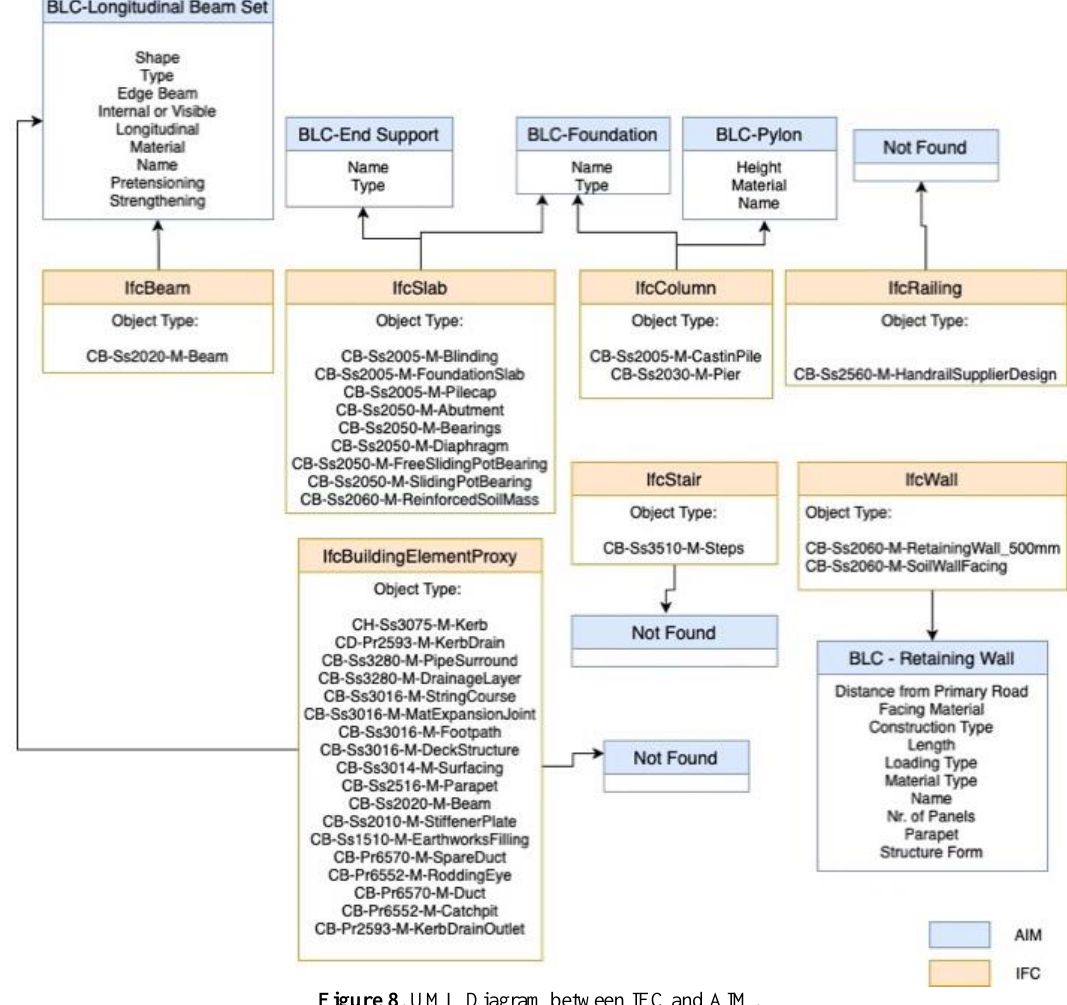
Figure 8 . UML Diagram between IFC and AIM.